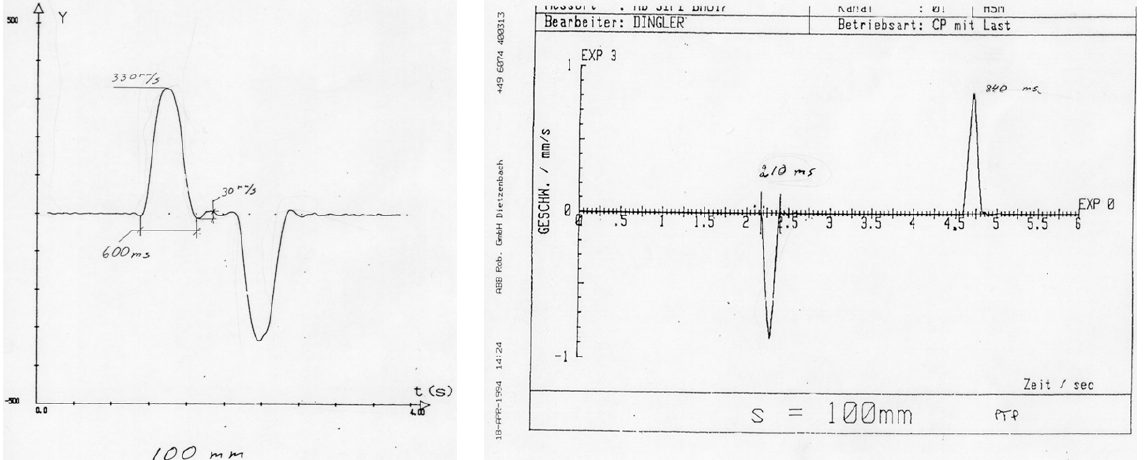
Figure 1: Registrations of speed as function of time for a 100 mm spot welding movement, at first in positive and then in negative direction. To the left a robot without model-based control and where the servo references have been filtered to avoid exciting mechanical resonances of the robot. To the right with the ABB model-based control as used at customer tests in 1994. Model-based control reduces the cycle time (a factor of 3 in this case), increases the max speed (from 330 to 840 mm/sec here) and reduces the settling